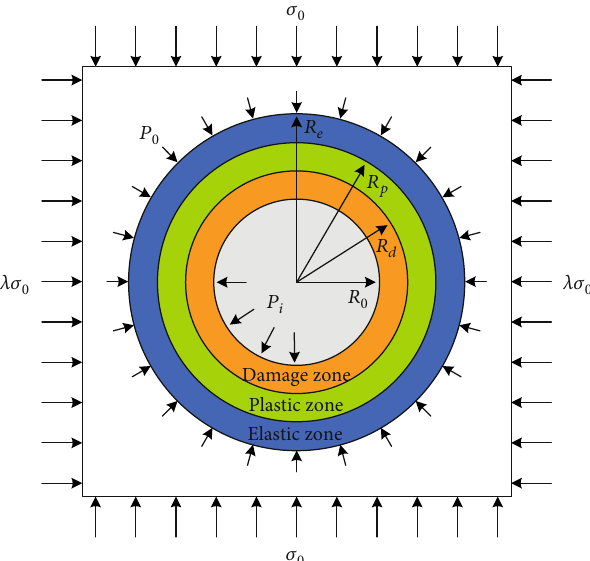
Figure 1: Mechanical model of tunnels subjected to a nonuniform stress fi eld in water-rich area.